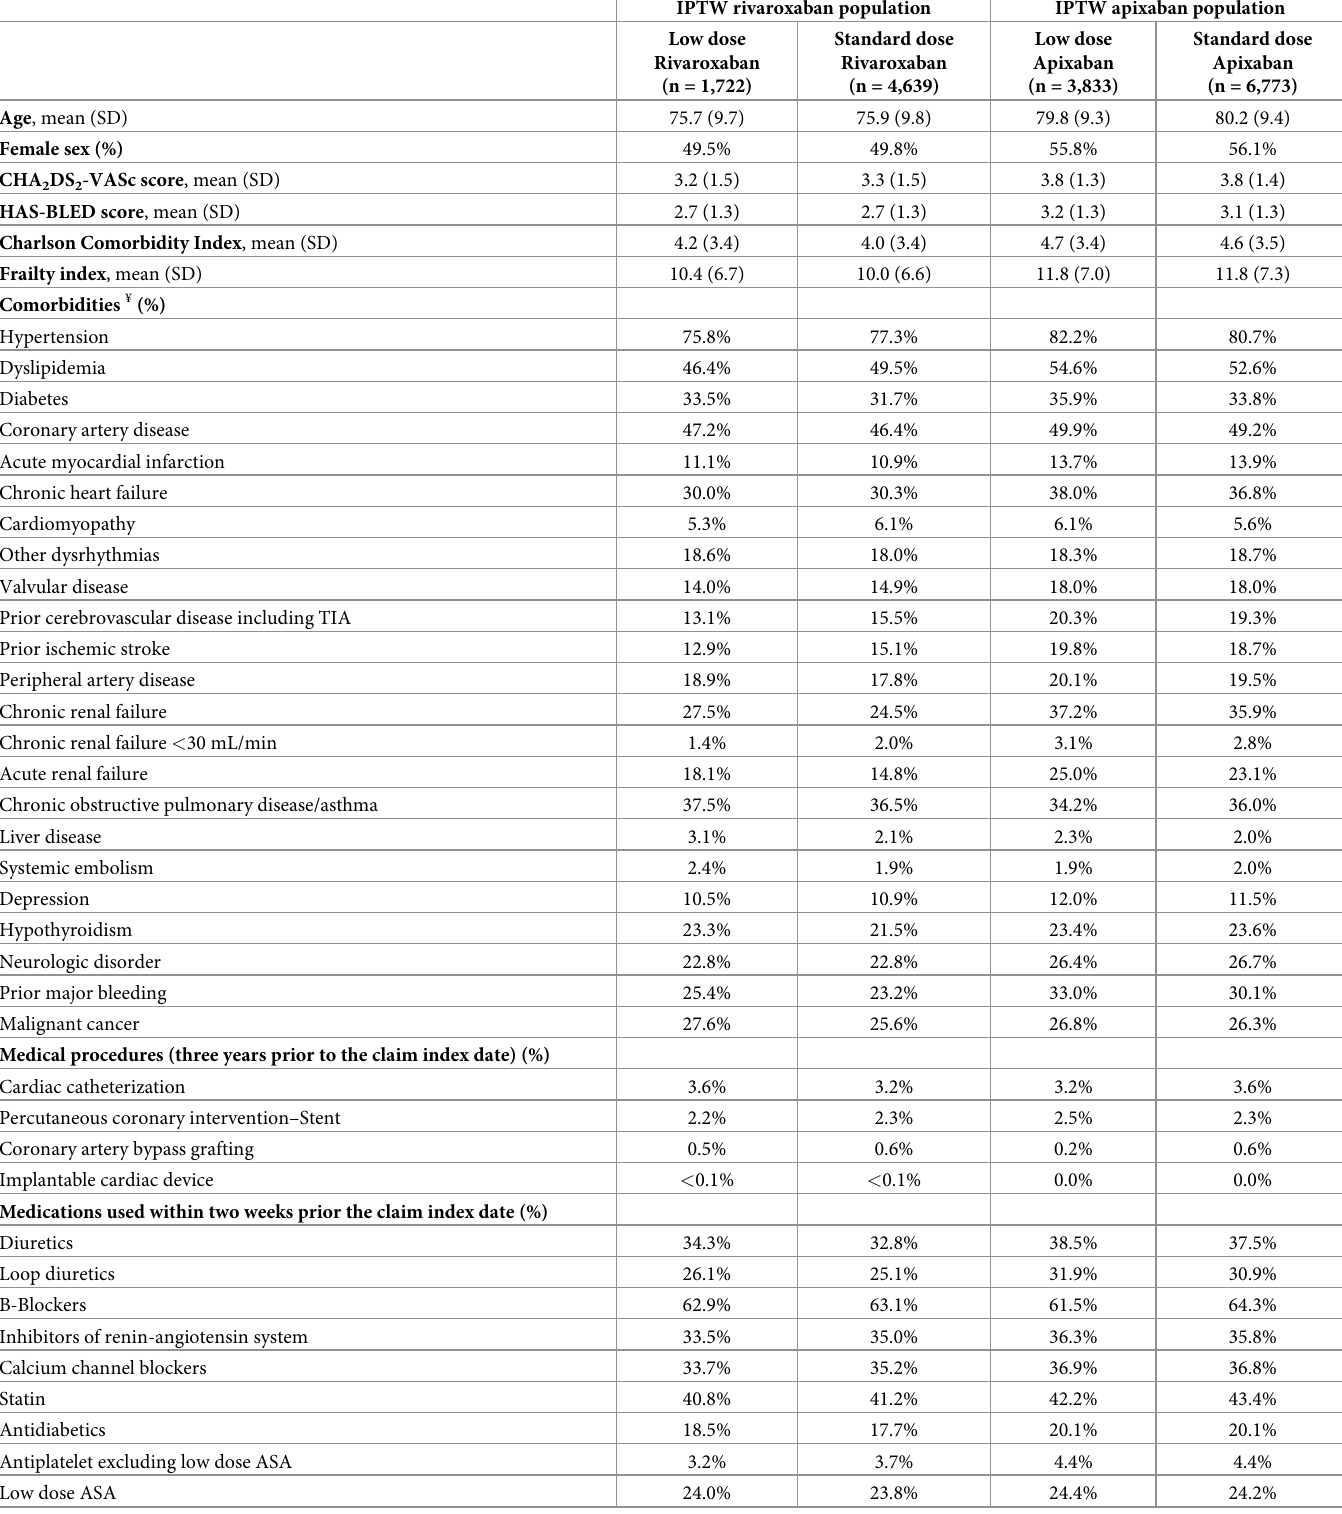
Table 1. Baseline characteristics of the atrial fibrillation populations after inverse probability of treatment